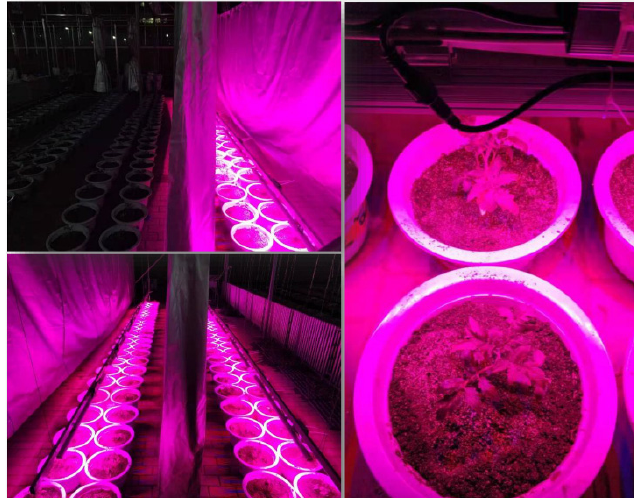
Figure 1. Schematic illustration of supplementary light treatments.